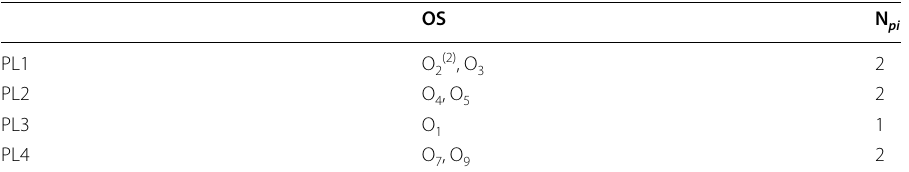
Table 7 The updated table of the OS list